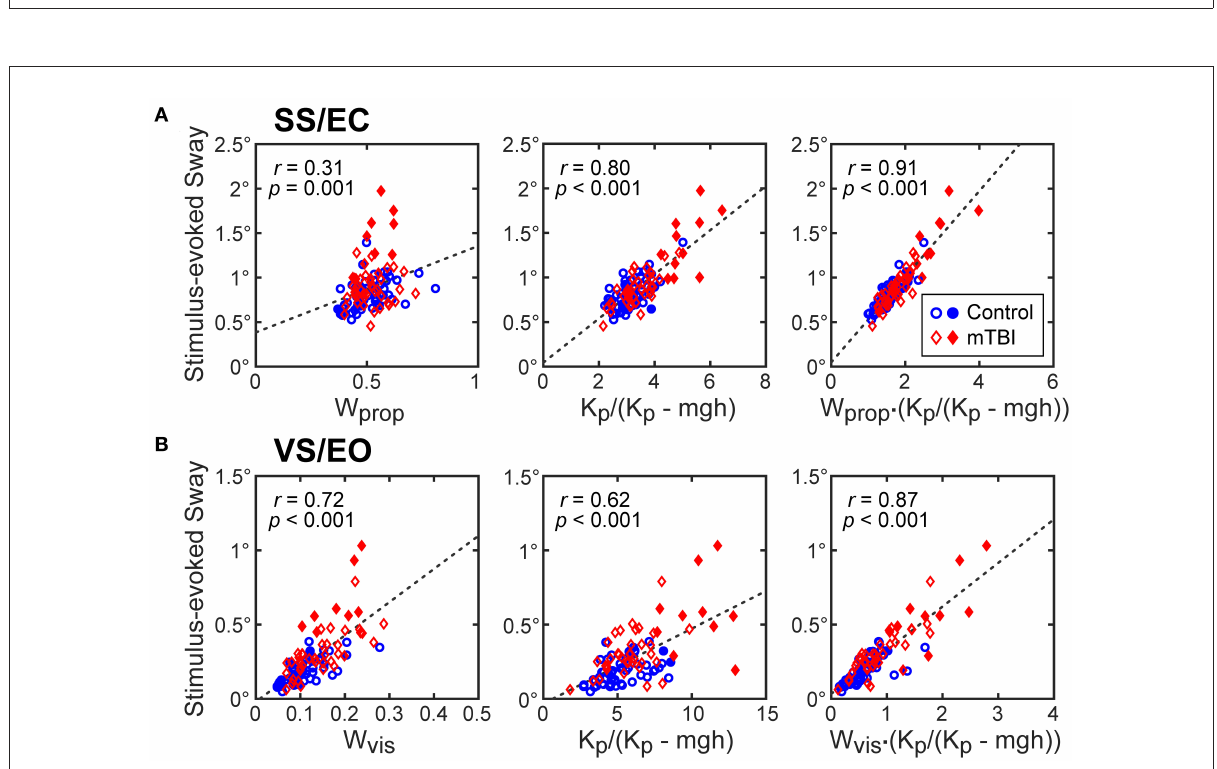
FIGURE5 CSMI parameters that account for the variation in RMS values of stimulus-evoked CoM sway. Stimulus-evoked sway measures in control (blue dots) and mTBI (red diamonds) are plotted against CSMI sensory weight parameter, the stiffness-related sway amplification factor K p /( K p - mgh ), and the product of these two terms for data from (A) surface-tilt stimulus with eyes closed (SS/EC) trials and (B) visual-tilt stimulus with eye open (VS/EO) trials. Filled symbols are for the subset of subjects with particularly long time delay and low normalized stiffness values (see Figure